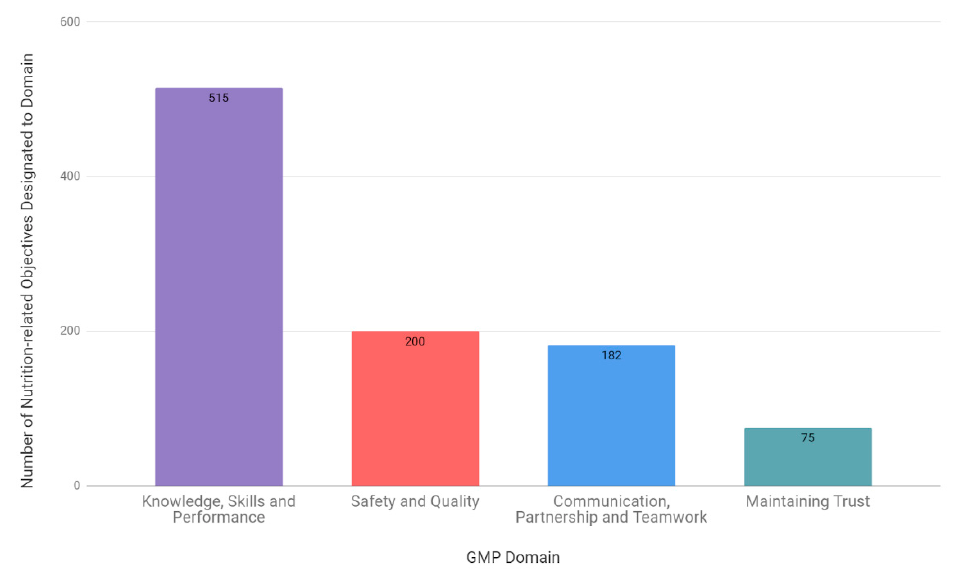
Figure 6. The number of nutrition-related objectives designated per Good Medical Practice (GMP) Domain across specialties.